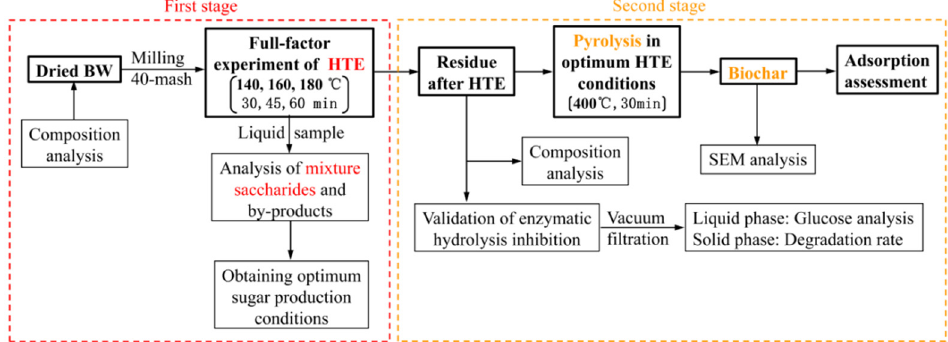
Figure 1. A schematic diagram for the two-stage thermal chemical process of BW.